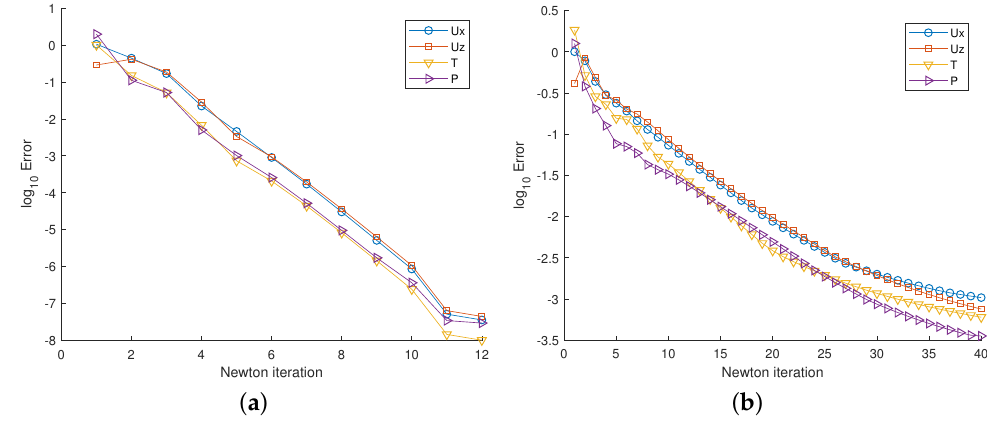
Figure 19. Graph of the log 10 of the errors in the velocity, temperature, and pressure fields for the Newton iterations: ( a ) R = 1300, Γ = 3.495, np = 2, mp = 1, N × M = 10 × 10; ( b ) R = 5000, Γ = 3.495, np = 8, mp = 2, N × M = 16 ×